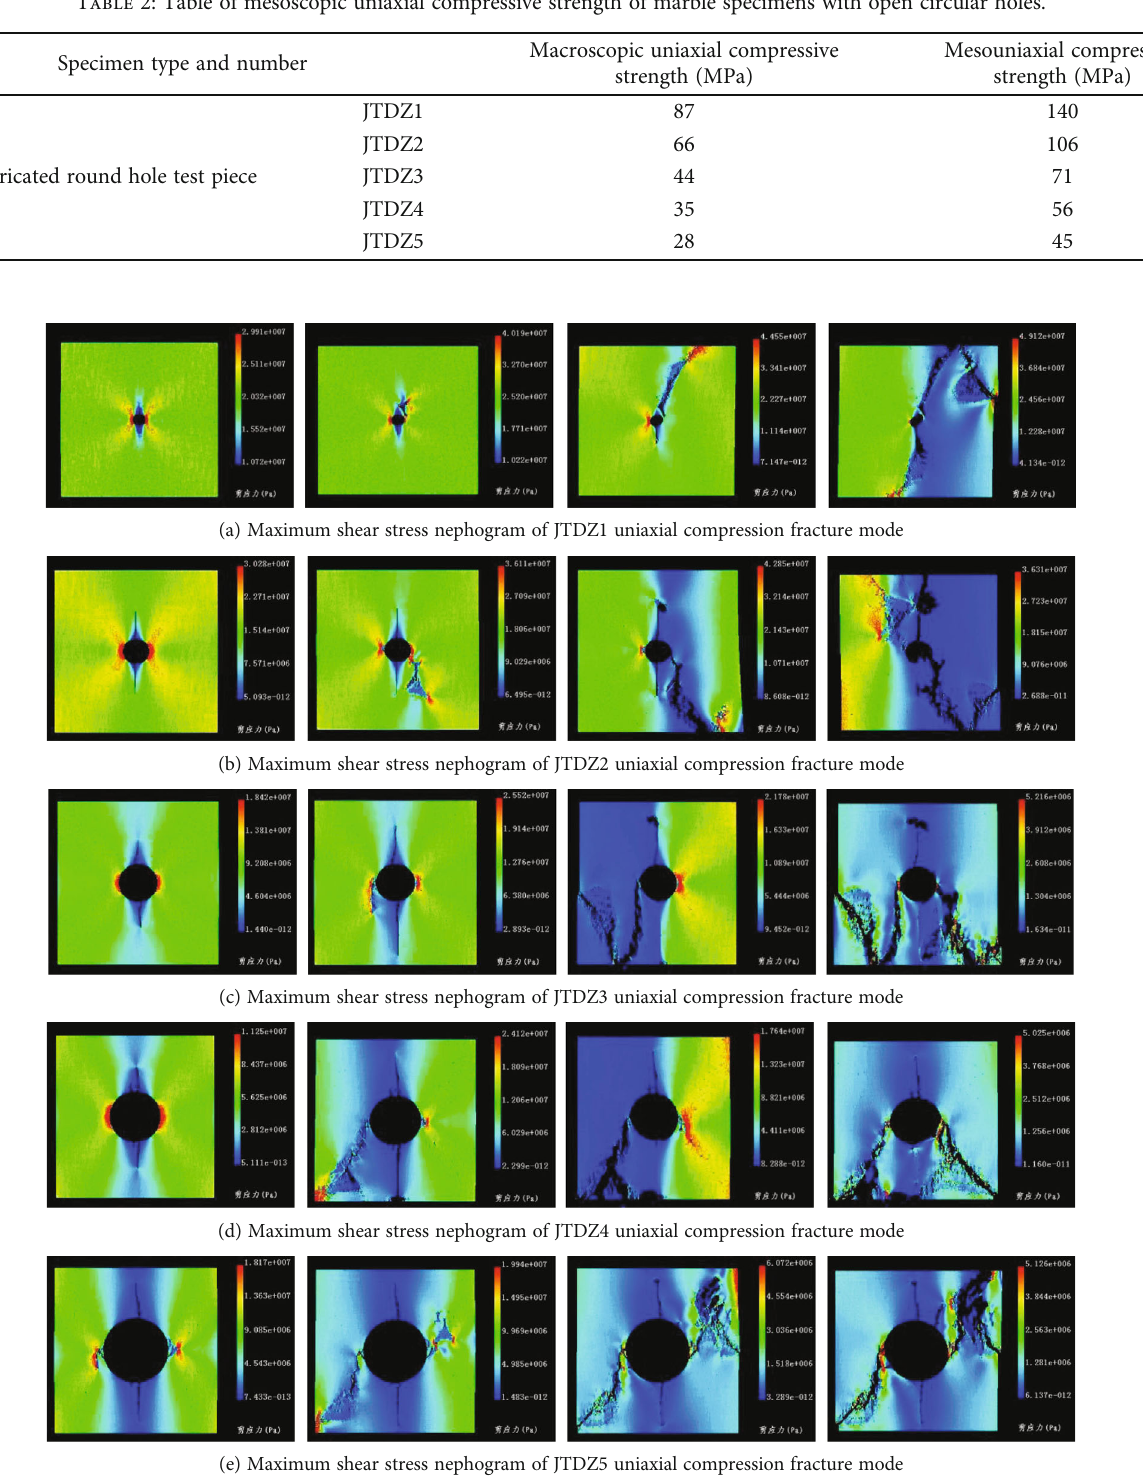
Figure 4: Maximum shear stress nephogram of uniaxial compression fracture